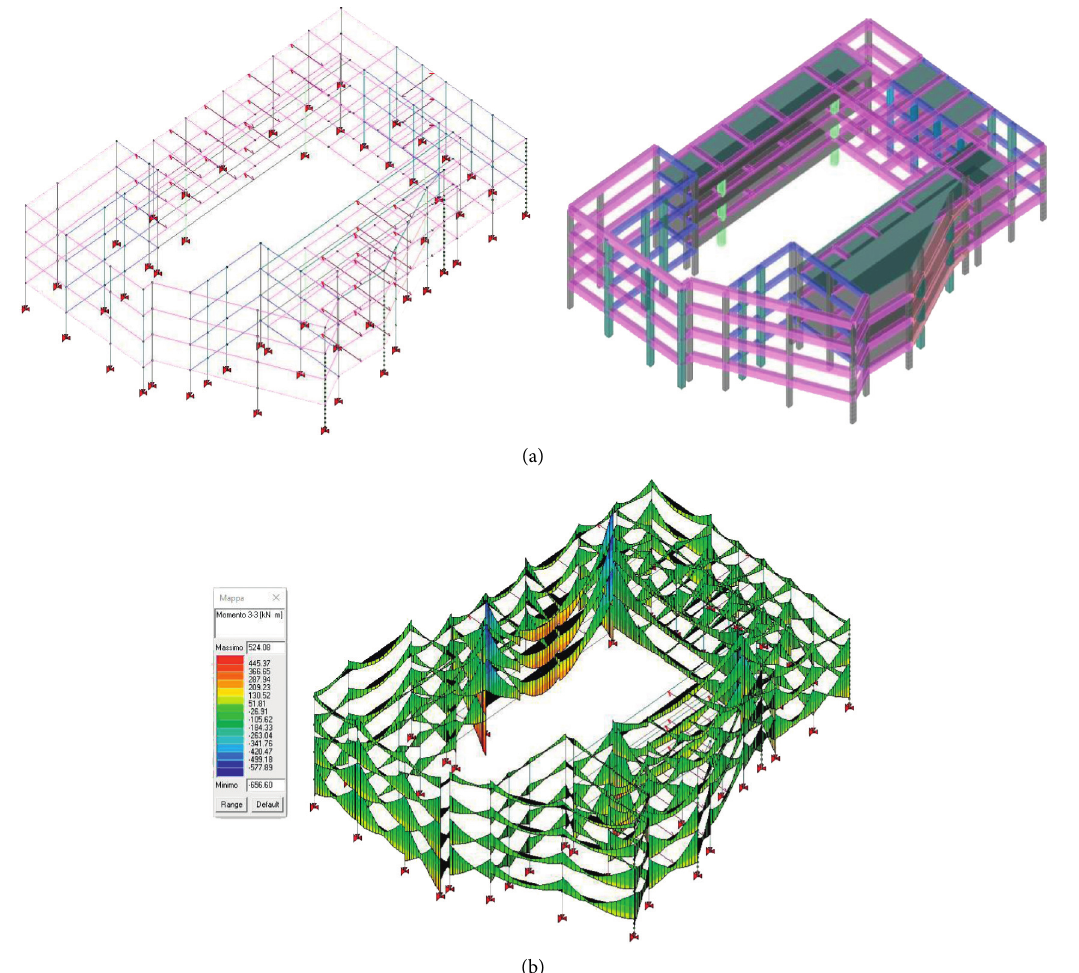
Figure 15: RC-structure global model in seismic load combination without any strengthening: (a) beam and 3D model and (b)